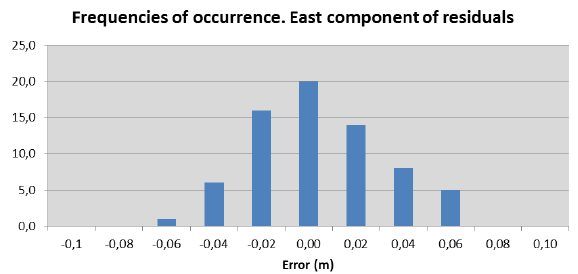
Figure 14. Frequency histogram of the deviations in East component of natural control points positions.